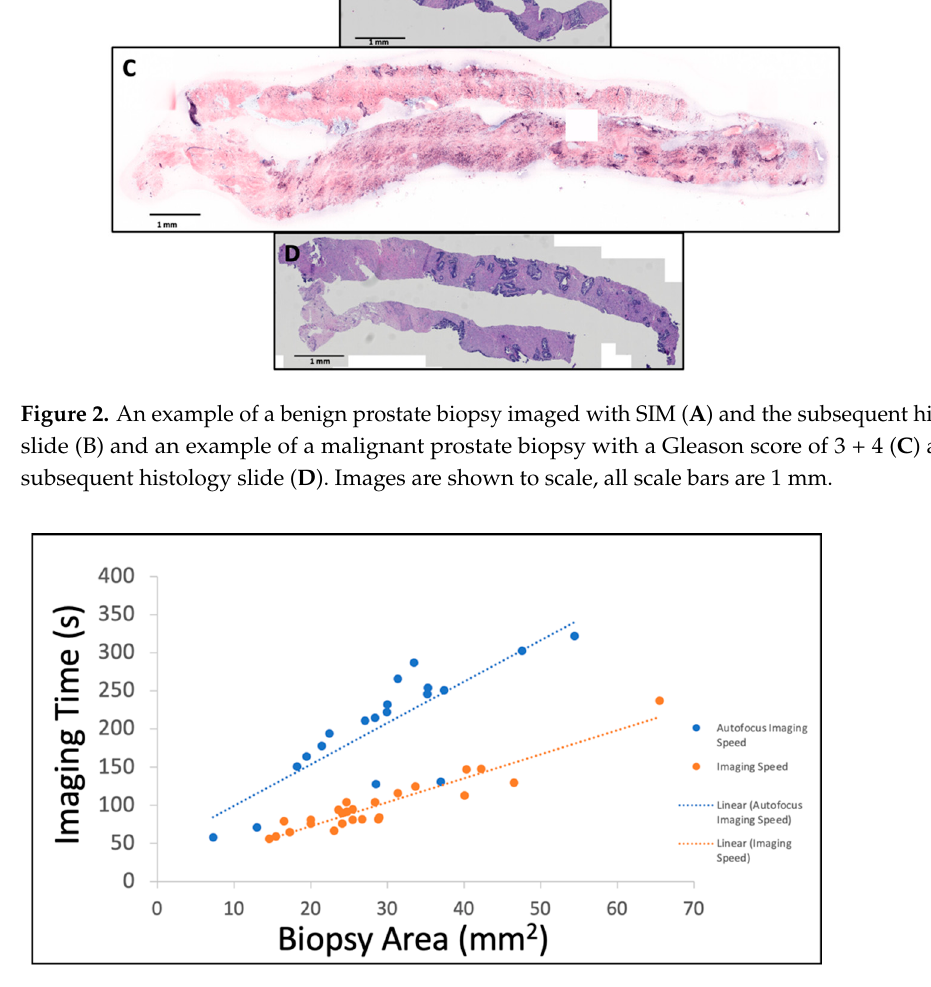
Figure 2. An example of a benign prostate biopsy imaged with SIM ( A ) and the subsequent histol- ogy slide (B) and an example of a malignant prostate biopsy with a Gleason score of 3 + 4 ( C ) and the subsequent histology slide ( D ). Images are shown to scale, all scale bars are 1 mm.